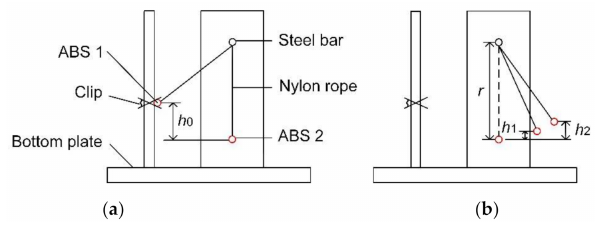
Figure 2. Schematic of double pendulum test of ABS–ABS collision. ( a ) before collision; ( b ) after